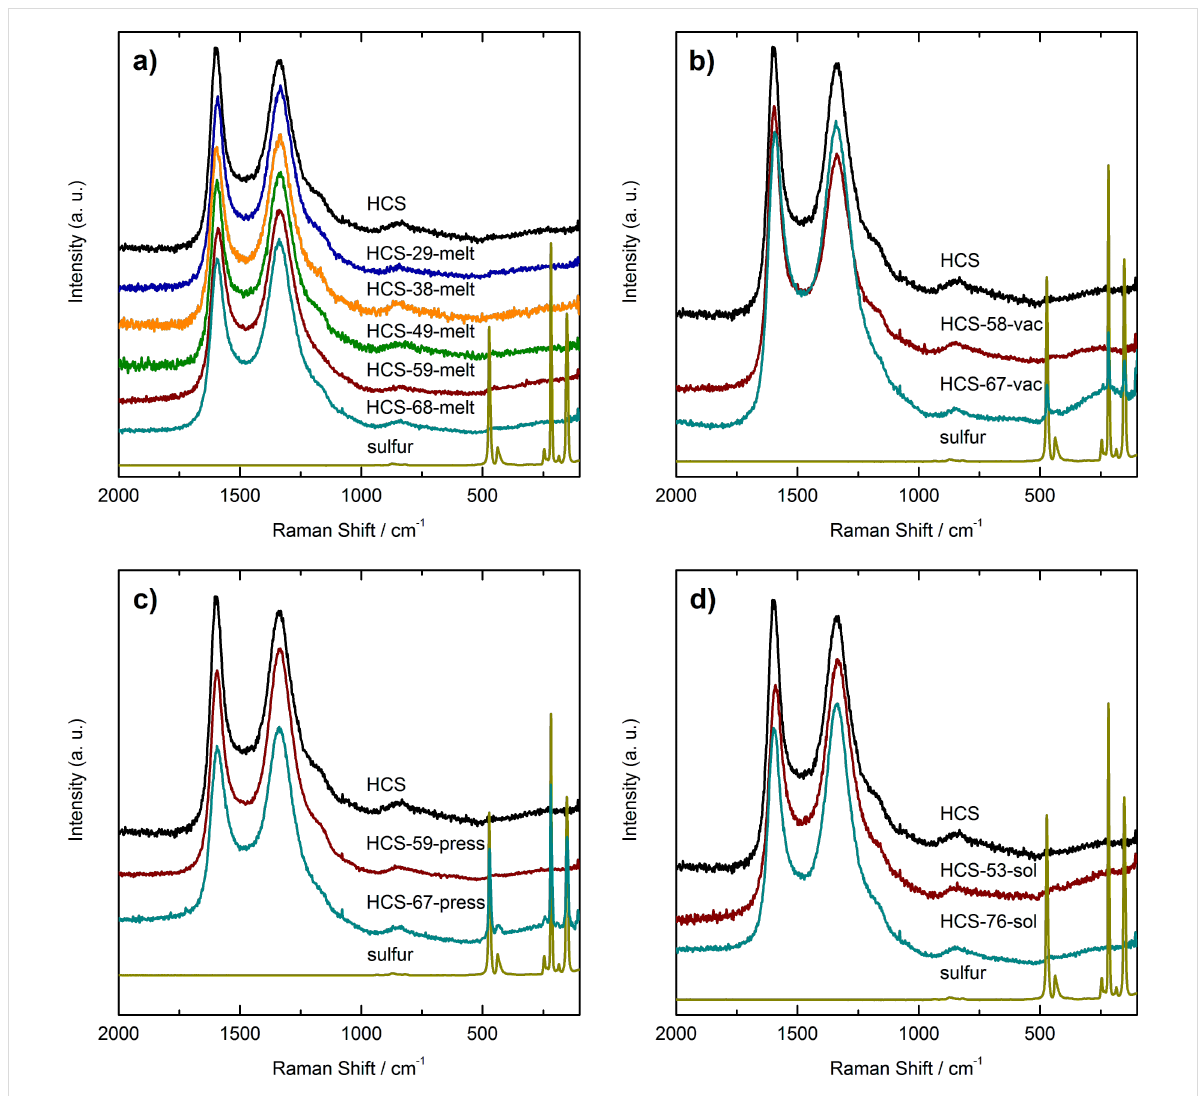
Figure 6: Raman spectra of HCS loaded with different amounts of sulfur by a) melt impregnation at ambient pressure, b) melt impregnation in vacuum, c) melt impregnation under increased pressure and d) impregnation from a solution of sulfur in carbon disulfide.